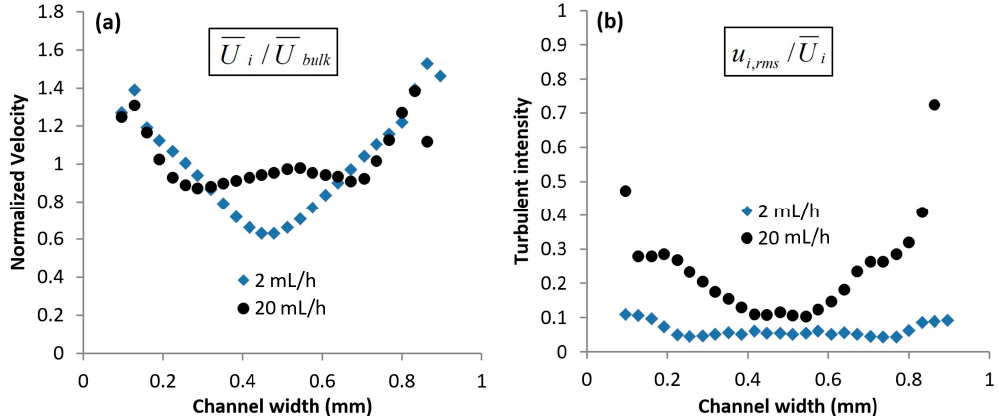
Figure 7. Mean flow statistics at δ = 0.3 mm. ( a ) Normalized axial velocity and ( b ) Turbulent intensities.